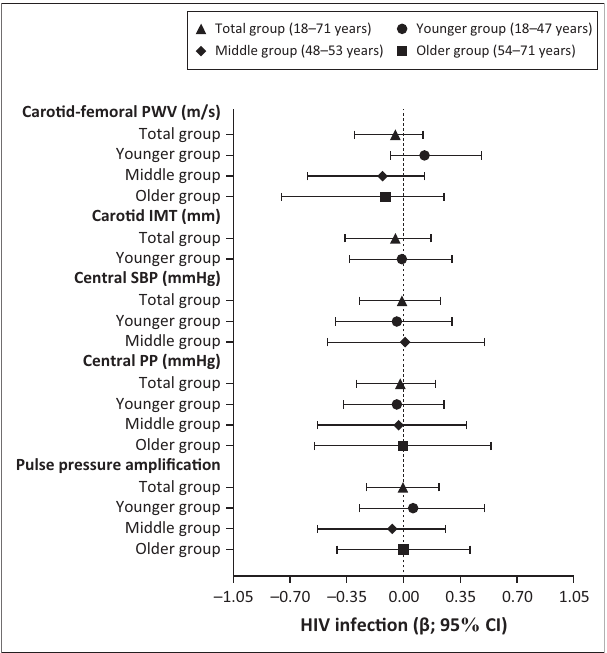
FIGURE 3: Associations between vascular measures and HIV status in the total group and in different age tertile groups. Models that were not significant (carotid IMT – middle and older group; central SBP – older group) were not included. Confounders included in all the models: HIV status, sex, body mass index, total cholesterol, gamma-glutamyl transferase, glycated haemoglobin, C-reactive protein, tobacco use, antiretroviral treatment use and anti- hypertensive medication use. Mean arterial pressure was additionally included in the models, with cfPWV, cIMT and PPA as the dependent variables. Heart rate was also included in the model, with PPA as the dependent